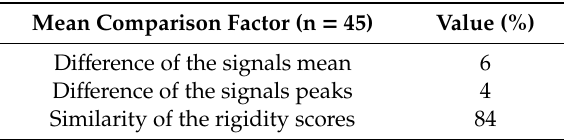
Figure 14. Previous iHandU hardware vs. SnapKi angular velocity signal obtained in a rigidity evaluation during Deep Brain Stimulation (DBS) surgery (mean signal and mean peaks highlighted). Table 6. Results of the comparison factors between the previous hardware and the SnapKi angular velocity signals (45 signals average).